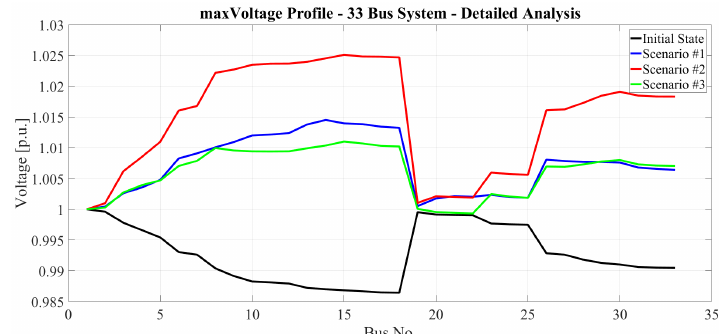
Figure 19. Detailed Analysis—Maximum Voltage profile for all Scenarios.